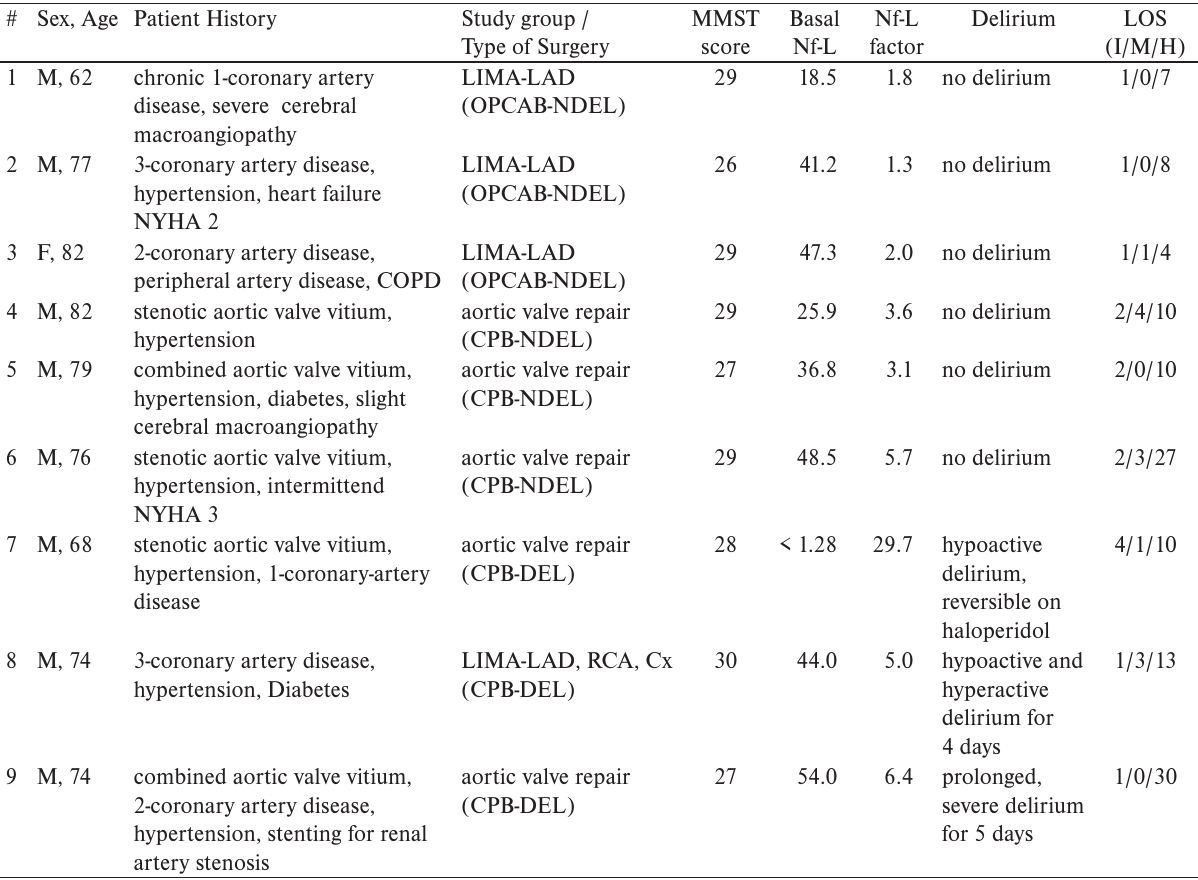
Table 1. Characteristics of the study